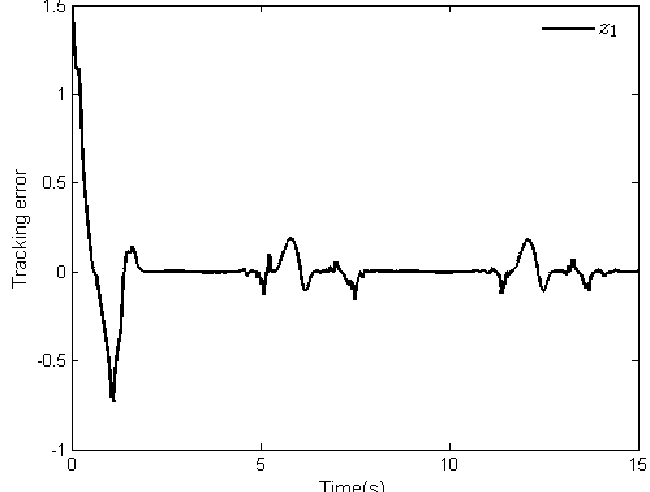
Figure 6. The trajectory of tracking error z 1 .